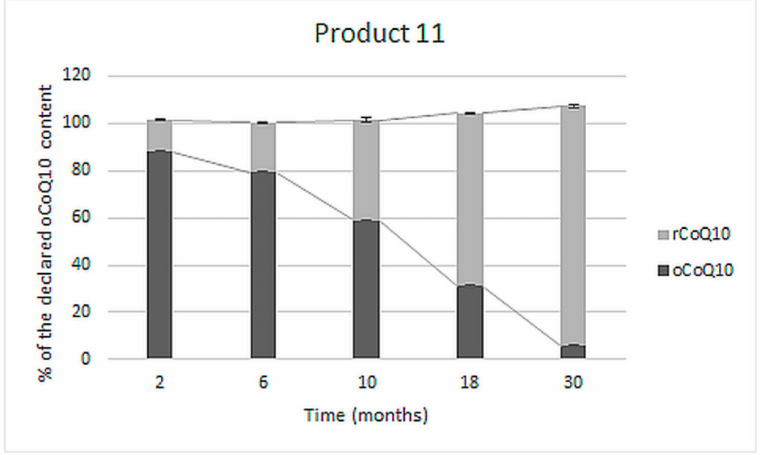
Figure 4. Long-term stability of rCoQ10, oCoQ10, and total CoQ10 in a finished product with specified oCoQ10 content evaluated at different time points after